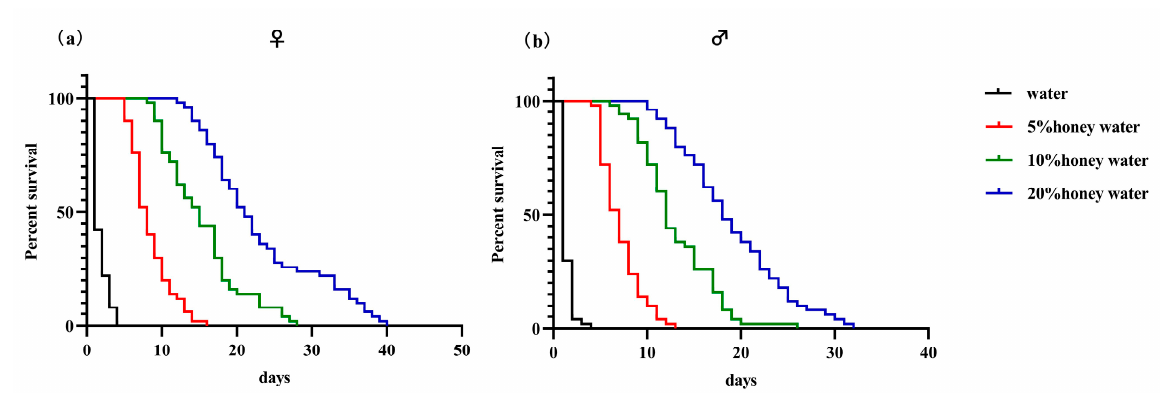
Figure 3. Survival for ( a ) Psyllaephagus sp. females and ( b ) males fed distilled water (black line), 5% honey water (red line), 10% honey water (green line), or 20% honey water (blue line). Table 1. Longevity (d) of Psyllaephagus sp. female and male adults feeding on different food (mean ± SE). Distilled Water 5% Honey Water